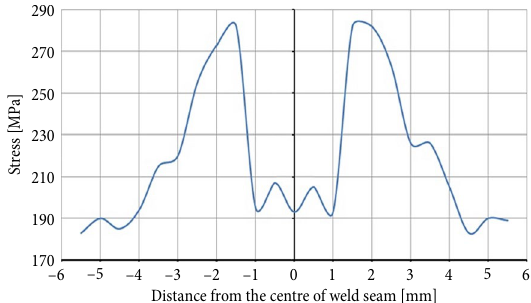
Fig. 12. Distribution of residual stresses at points of the control line (Dzerkelis et al. 2012a,